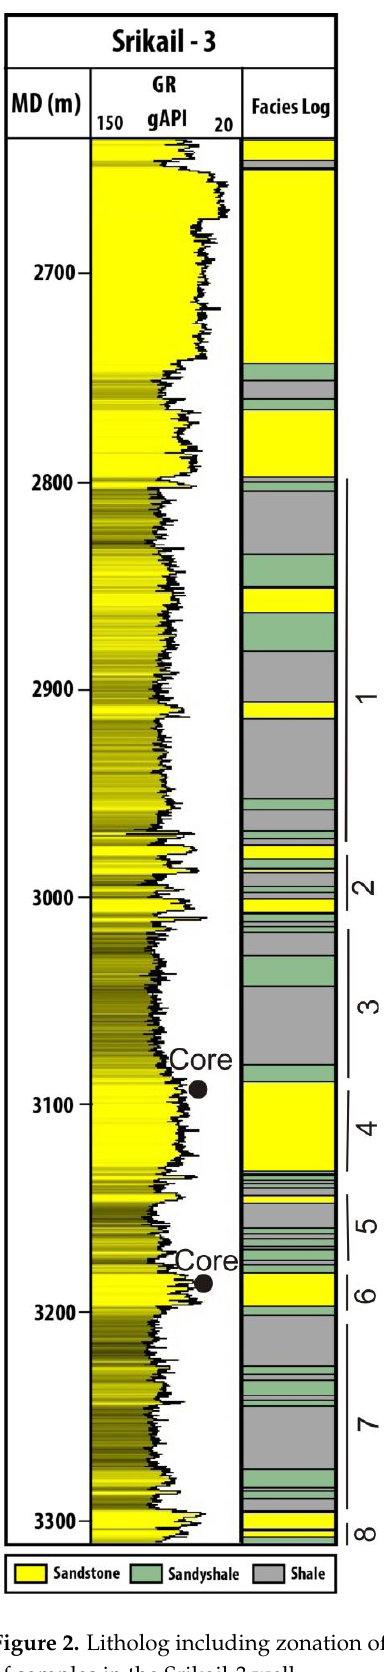
Figure 2. Litholog including zonation of gross lithology (1, 2, 3, 4, 5, 6, 7, 8) of reservoir and location of samples in the Srikail-3 well.